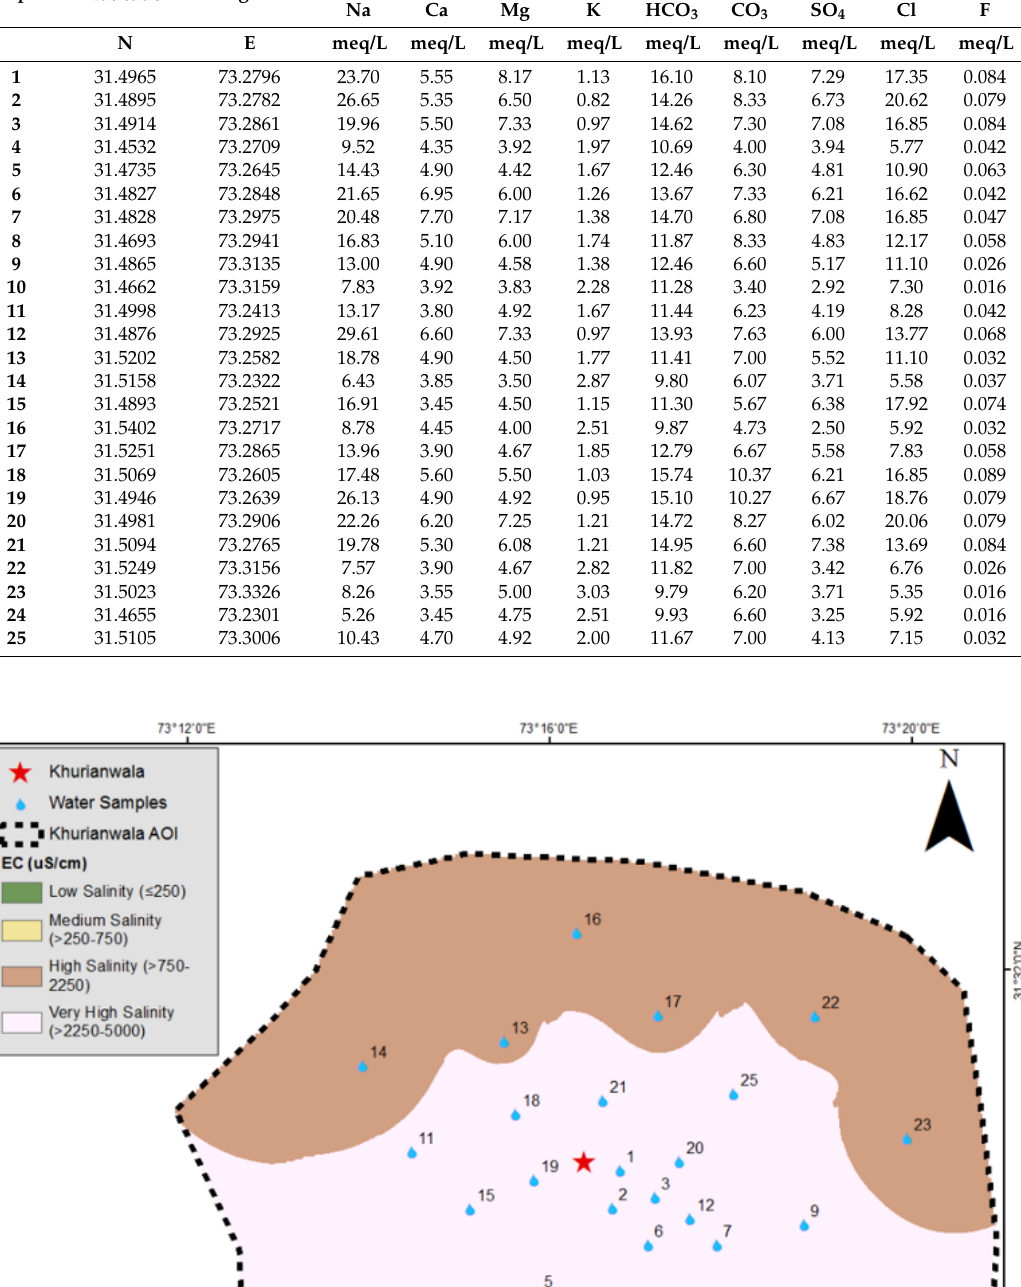
Table 6. Cations and anions for the calculation of piper plot and % error of ion balance. Samples